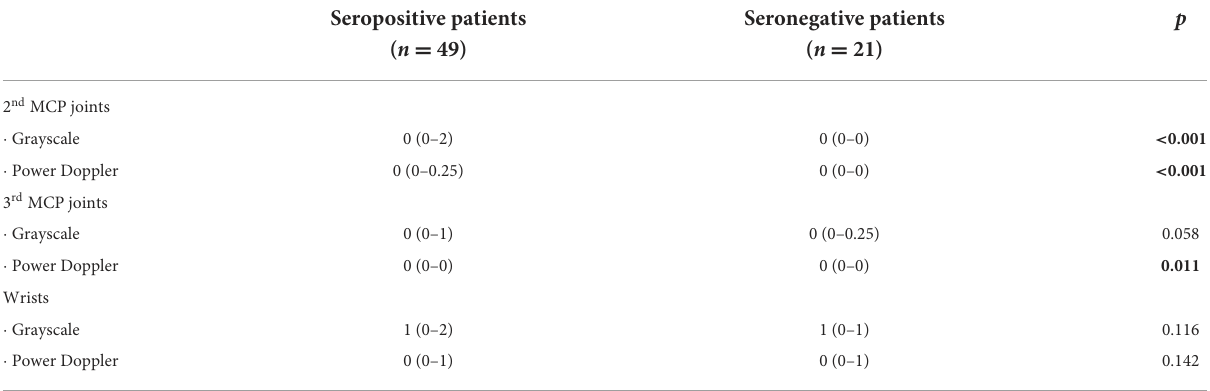
TABLE 4 Ultrasonographic findings, according to the severity of the lesions, in hand joints.